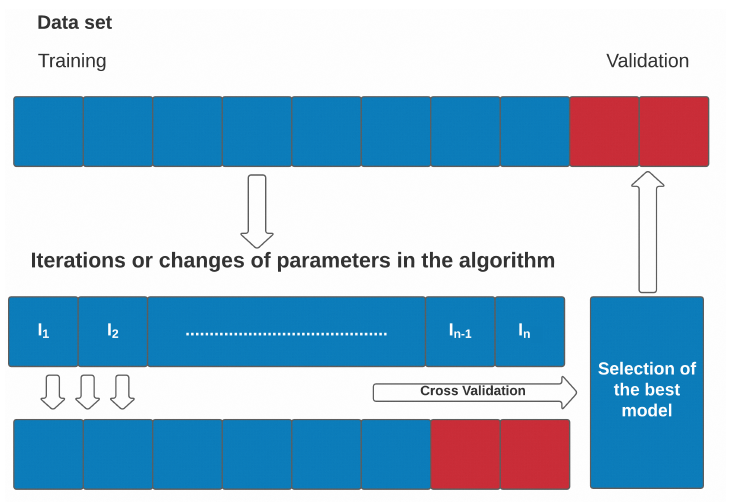
Figure 3. Training and validation